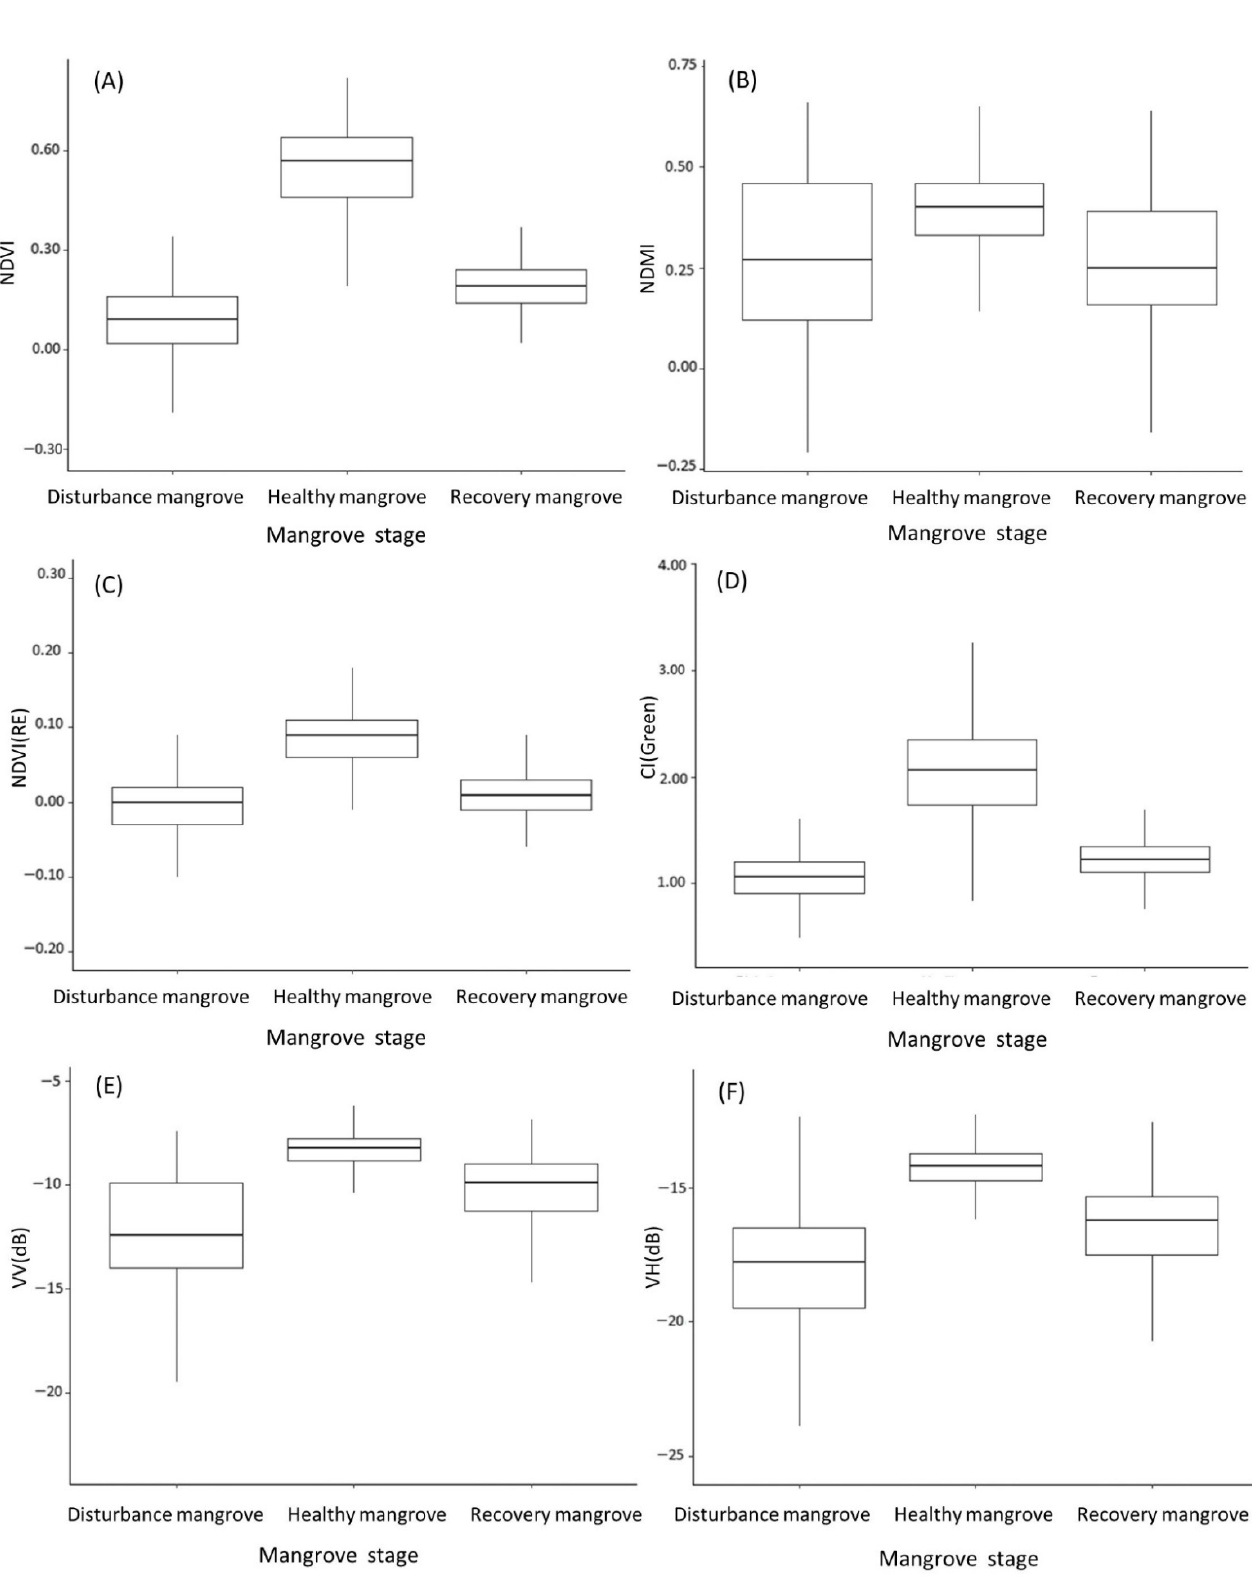
Figure 4. Boxplots of each mangrove stage using different vegetations indices and SAR variables. Boxplots of ( A ) NDVI, ( B ) NDMI, ( C ) NDVI RE ( D ) CI Green ( E ) VV and ( F ) VH from multiple-incidence angles for each mangrove stage.